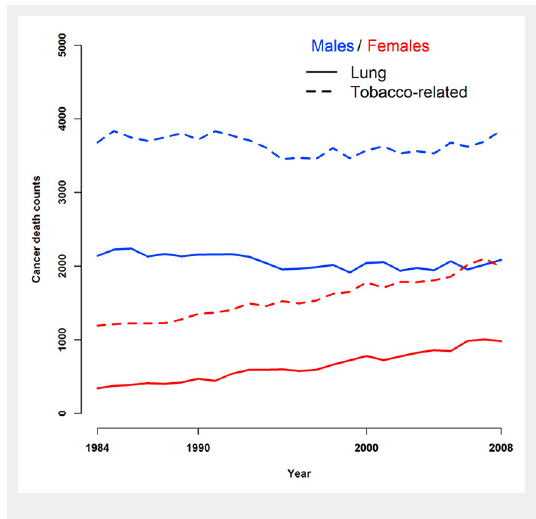
Figure 2 Overall lung and all tobacco-related cancer deaths observed during 1984–2008 at the national level for males and